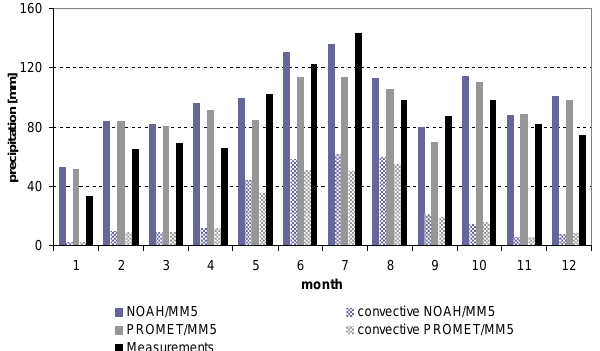
Figure 8: Monthly convective and total precipitation of MM5 simulations coupled with Noah and PROMET compared to measurements. Fig. 8. Monthly convective and total precipitation of MM5 simu- lations coupled with Noah-LSM and PROMET compared to mea- Convective precipitation events are strongly linked to the underlying land surfaces. Since the surements. land surface classifications and extensions differ between the two models, different amounts of convective precipitation events are observed between the simulations, in particular in the warm, high energy summer months. The lower values in the monthly precipitation from May to September in the results of PROMET /MM5 are due to the 20 % decrease in the simulation of convective precipitation, versus a 9% decrease in non-convective precipitation (Figure 8). Heavy precipitation events, such as in May 1999, are not properly reproduced in the Upper- Danube in either both simulations as heavy precipitations are generally underestimated (Zängl, 2007b).